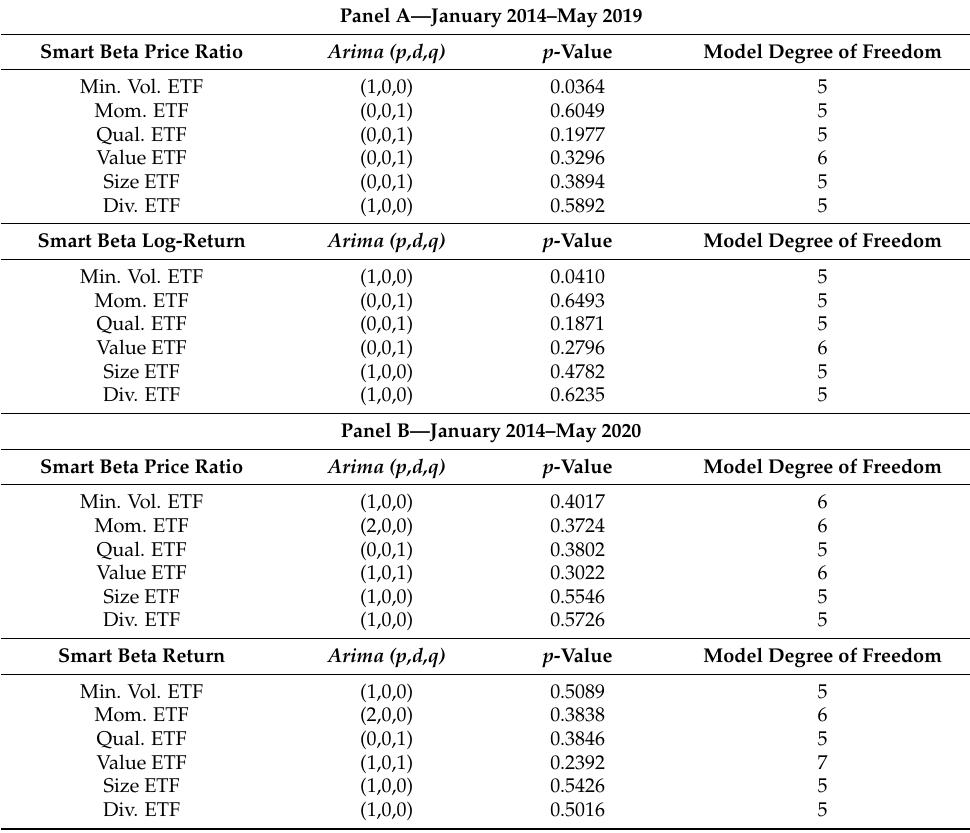
Table A1. Details on the results of auto.arima() corresponding to model (9)–(10) in Table 3.